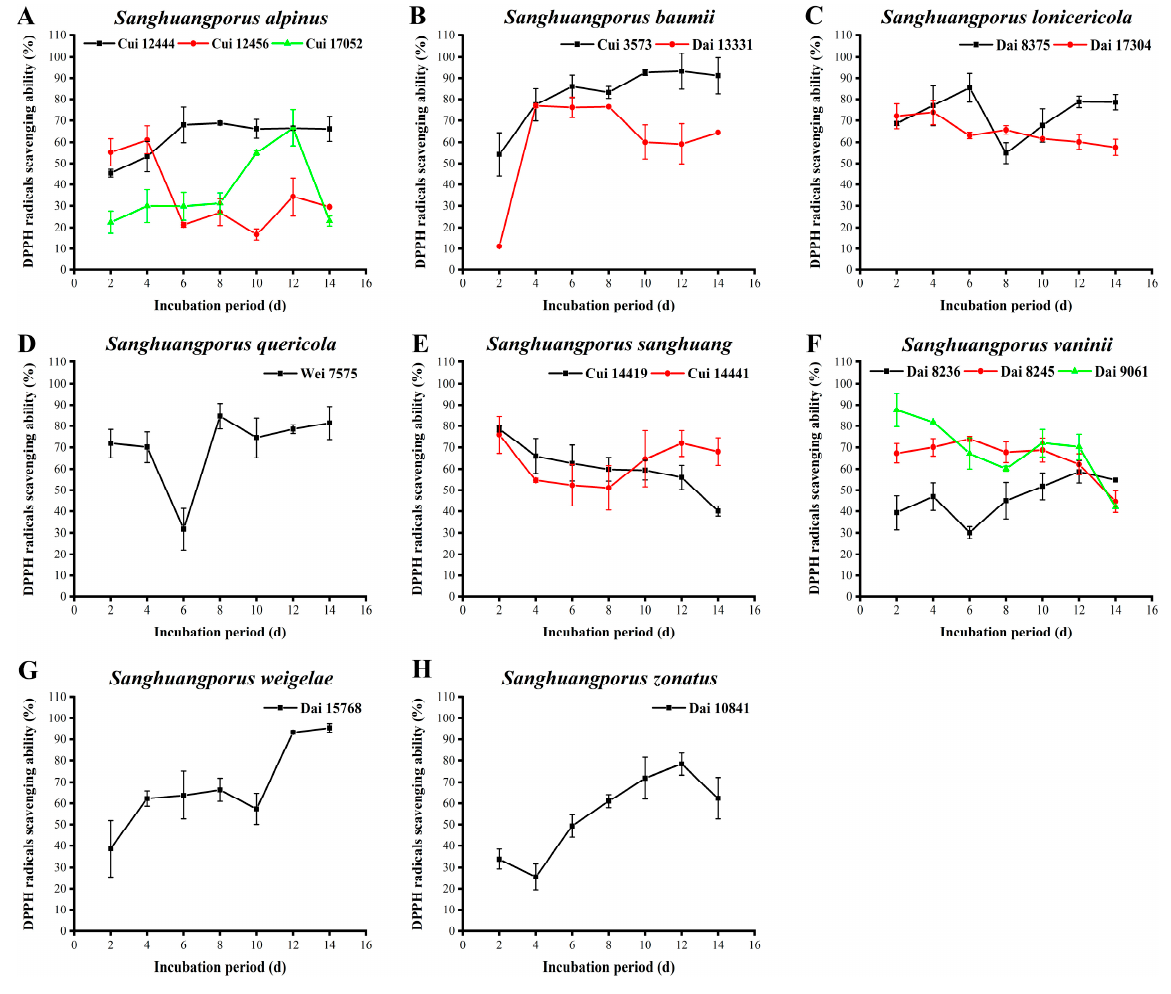
Figure 9. Variations in DPPH radical scavenging activities during submerged fermentation of